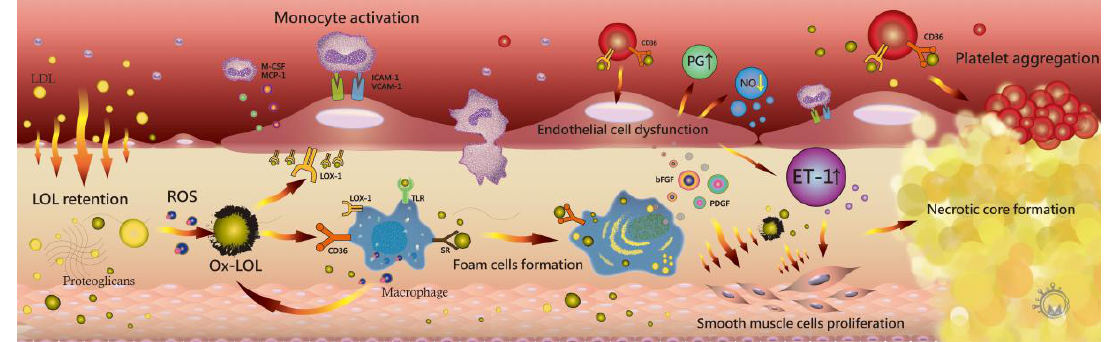
Figure 1. Small low-density lipoproteins (LDLs) penetrate the endothelial barrier and bind to proteoglycans via apolipoprotein B100 to retain in the subendothelial space. LDL is oxidized (ox-LDL) and induces several pro-inflammatory conditions via lectin-like oxidized LDL receptor-1 (LOX-1). The upregulation of intercellular adhesion molecule-1 (ICAM-1) and vascular-cell adhesion molecule-1 (VCAM-1) by ox-LDL increase monocyte and inflammatory cell adhesion on the endothelium. Ox-LDL particles stimulate endothelial cells and smooth muscle cells (SMCs) to secrete monocyte chemotactic protein-1 (MCP-1) and monocyte colony stimulating factor (M-CSF), with both factors inducing monocyte recruitment. Ox-LDL promotes an increased in reactive oxygen species (ROS) and inhibits nitric oxide production. Monocytes differentiate into macrophages and express scavenger receptors (SRs), cluster of differentiation 36 (CD36), LOX-1, and Toll-like receptors (TLRs). Ox-LDL–CD36 interaction induces monocyte differentiation, macrophage activation, and macrophage retention, and macrophage SRs increase ox-LDL uptake and foam-cell formation. The retention of ox-LDL leads to foam cell apoptosis and inflammatory progression. Ox-LDLs also increase the expression of growth factors, including platelet-derived growth factor (PDGF) for migration and basic fibroblast growth factor (bFGF) for proliferation, on SMCs. SMC proliferation contributes to the thickening of atherosclerotic plaques and formation of a necrotic core. The ox-LDL–CD36 interaction in resting platelets causes platelet aggregation and activation, with activated platelets expressing LOX-1 to mediate adhesion to endothelial cells and enhance endothelin-1 release. The endothelial function is impaired along with decreasing nitric oxide production and increasing prostaglandin synthesis.